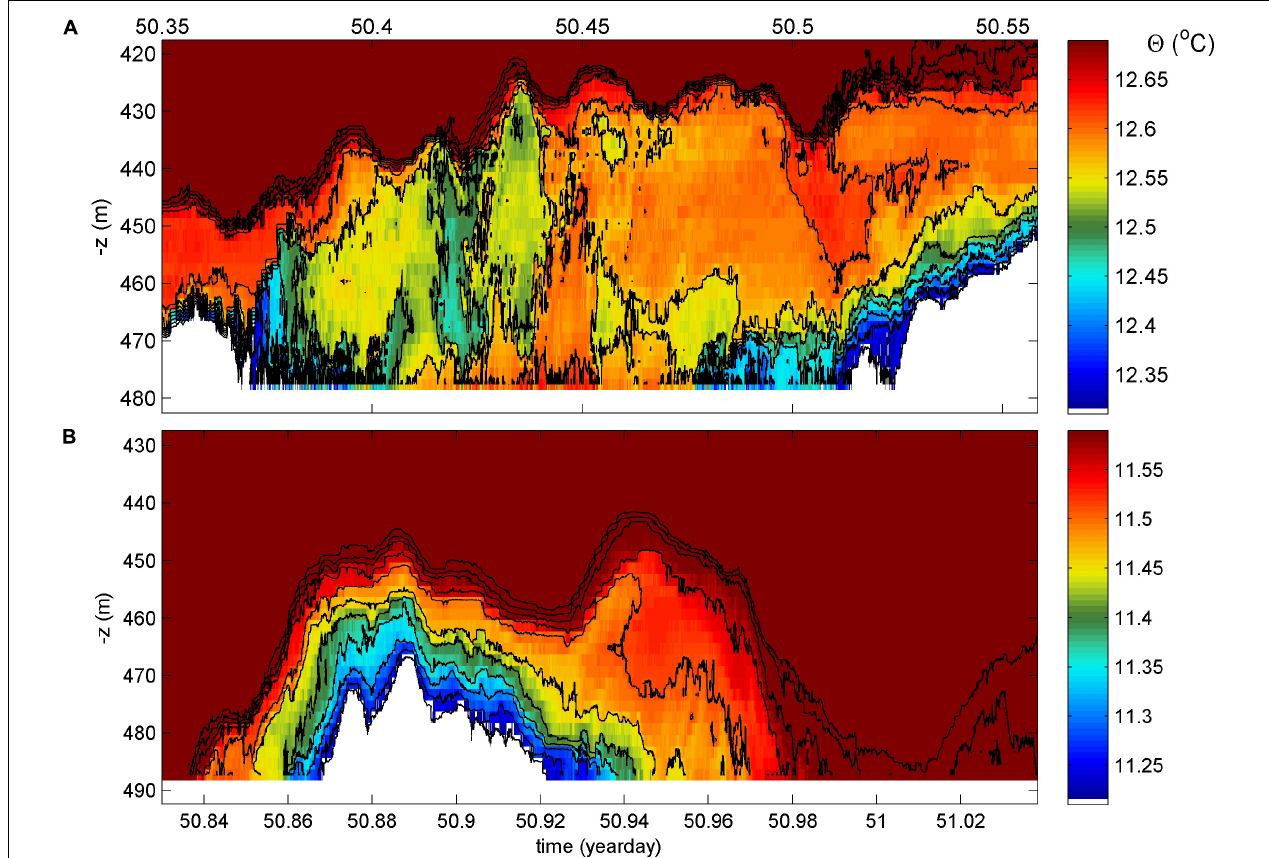
FIGURE 11 | Five hour near-bottom details of Figure 5 , with different color ranges and contours every 0.05 ◦ C. (A) MN. (B)